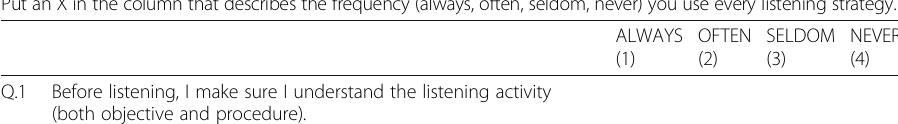
Table 1 General listening strategy